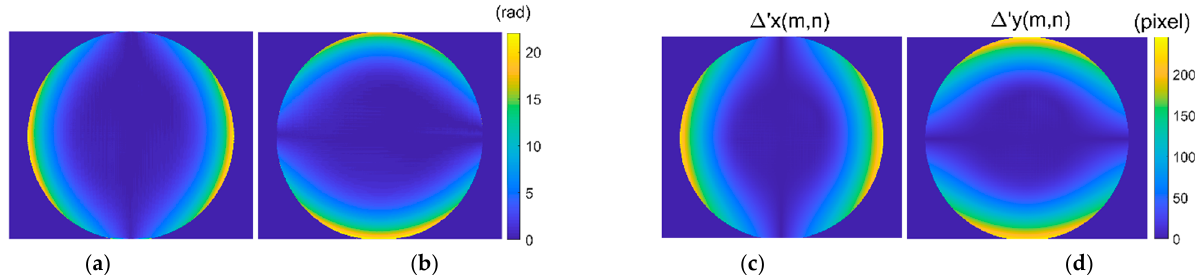
2048 × 2448 pixels; ( c ) ∆ (cid:48) x ( m , n ) of size 2496 × 2984 pixels; ( d ) ∆ (cid:48) y ( m , n ) of size 2496 × 2984 pixels.